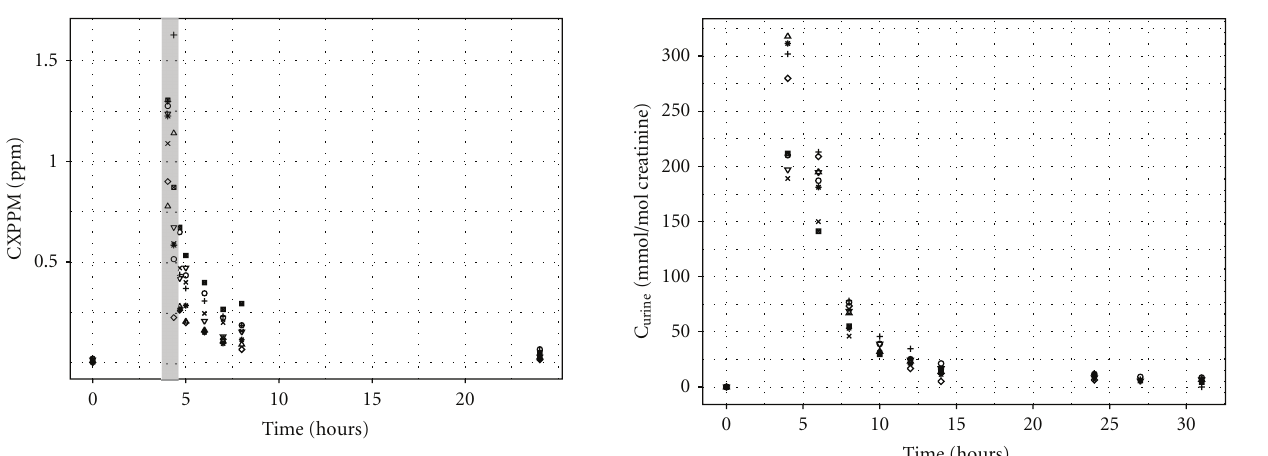
Figure 2: Exhaled m -xylene. Data from eight volunteers used in reverse dosimetry. The data points enclosed within the grey bar were excluded from the final exposure reconstruction simulations.